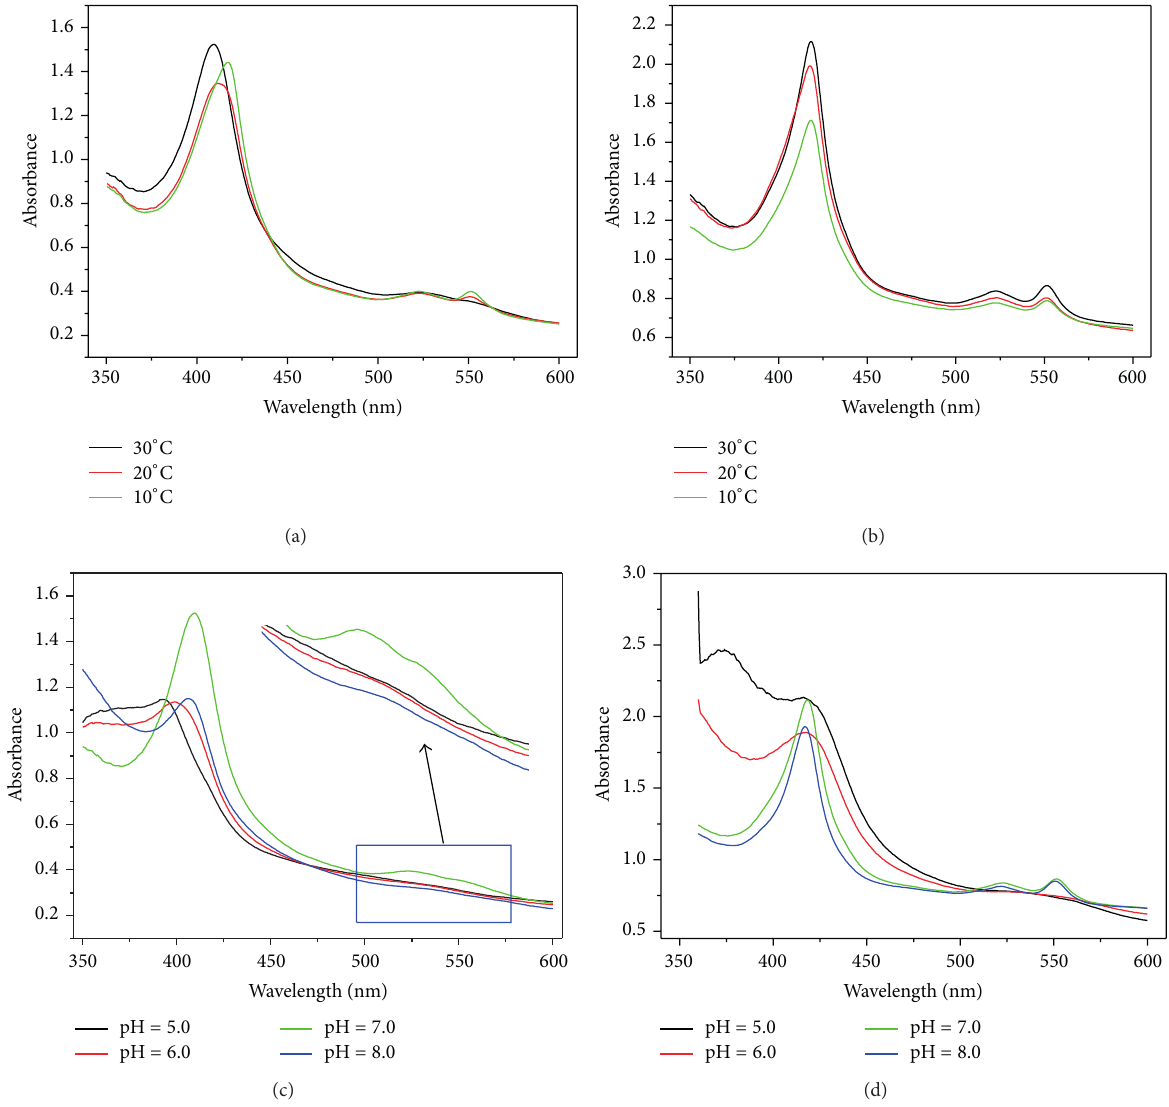
Figure 3: Electronic absorption spectra of G. sulfurreducens under various temperatures at pH 7.0 in oxidized state (a) and reduced state (b); electronic absorption spectra under various pH values at 30 ∘ C in oxidized state (c) and reduced state